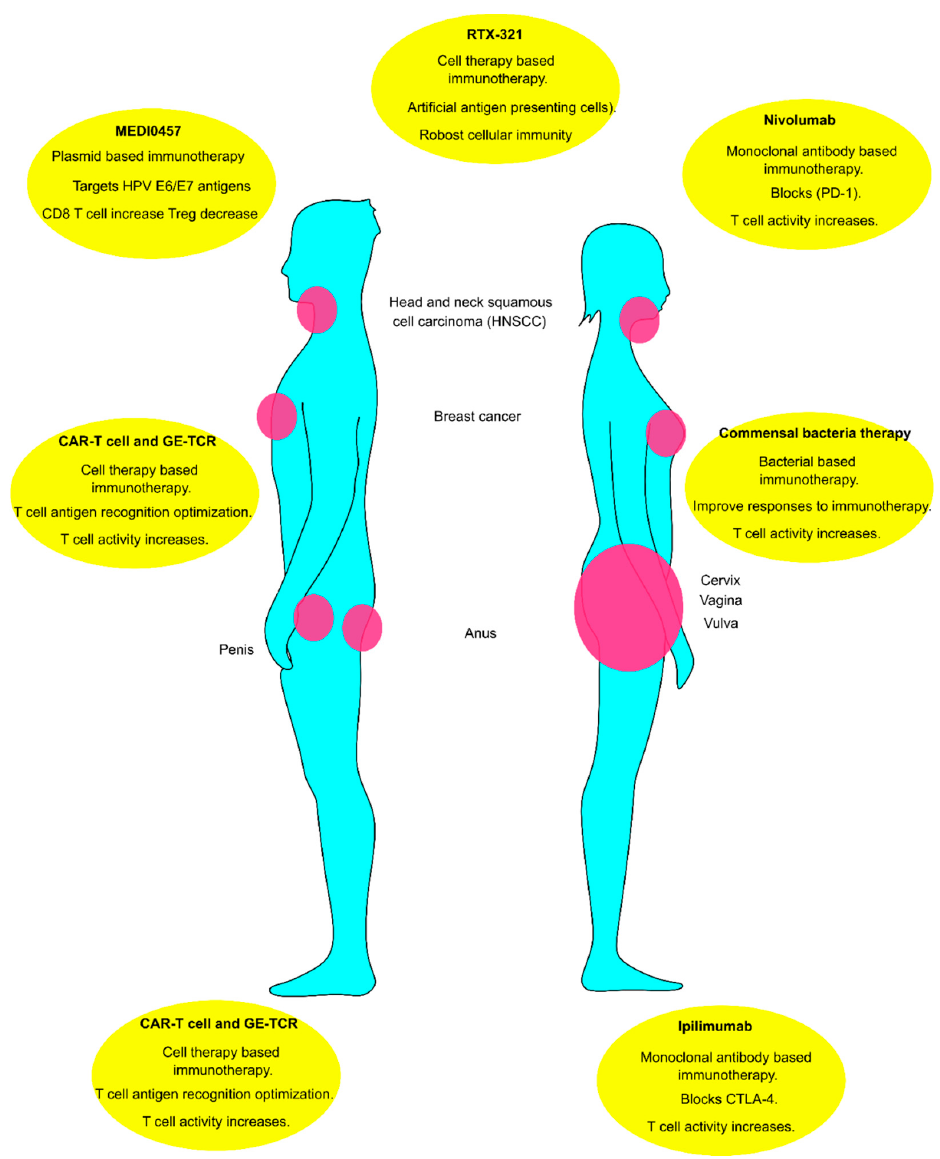
Figure 5. Immunotherapy of HPV-related tumors can be classified into monoclonal antibodies therapy, cell therapy, engineered nucleic acid-based therapies, and bacterial or engineered bacterial therapy. Monoclonal antibodies such as ipilimumab and Nivolumab that target CTLA-4 and PD-1